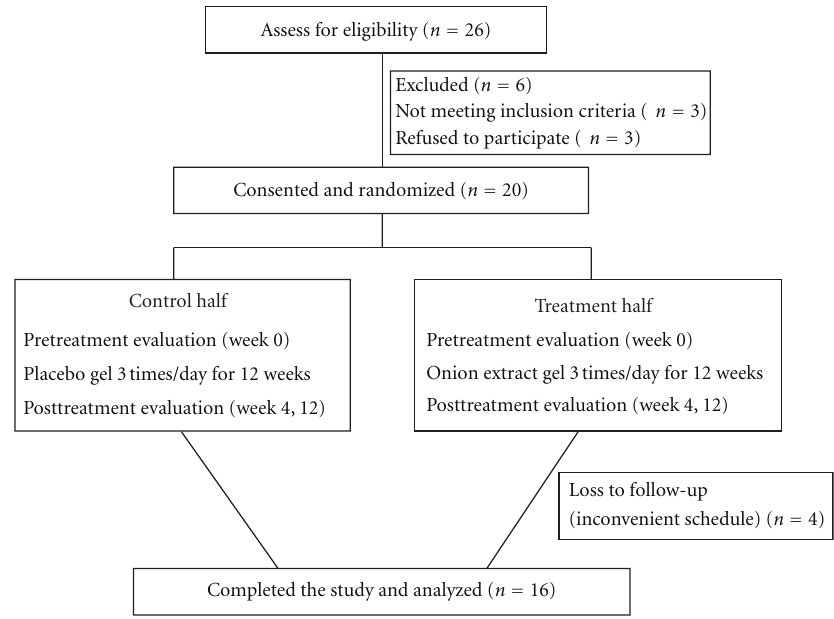
Figure 1: The flow chart showing number of eligible, refused to participate, recruited, randomized, and completed subjects.